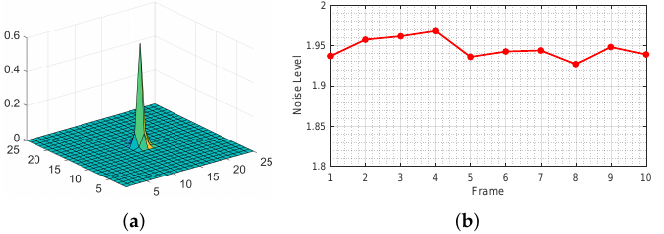
Figure 14. Visualization of the estimated blur kernel and noise level obtained by the degradation estimation module on the San-ya data. ( a ) Estimated blur kernel. The standard deviation of all 10 frames is 0.5. ( b ) Estimated noise level. The noise level of different frames fluctuates in a small range between 1.92 and 1.97. Table 4. Results of the ablation study on evaluating the effectiveness of each module in VSSR, bold indicates the best and italic underline indicates the second-best performance. “ (cid:88) ” denotes the module is adopted while “ (cid:55) ” denotes the module is not adopted. Module PSNR SSIM Degradation Estimation